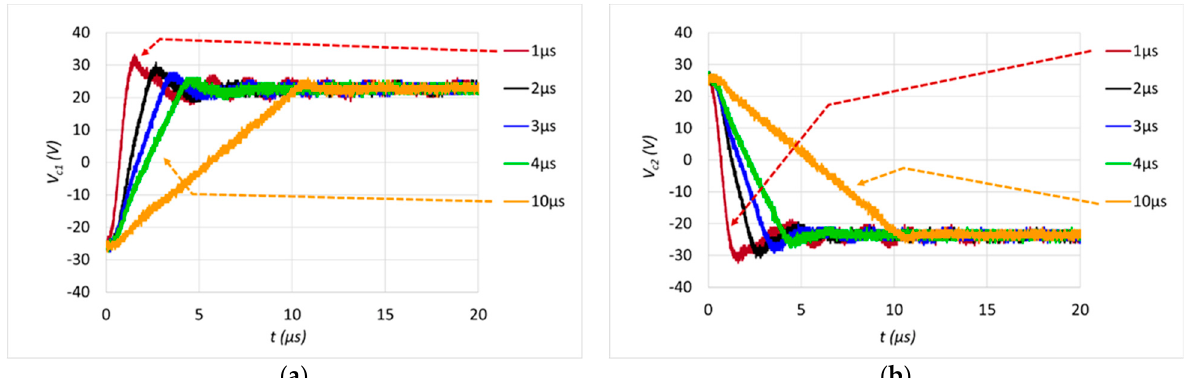
Figure 18. Measured transient voltage waveforms of actuator 1 ( a ) and actuator 2 ( b ).